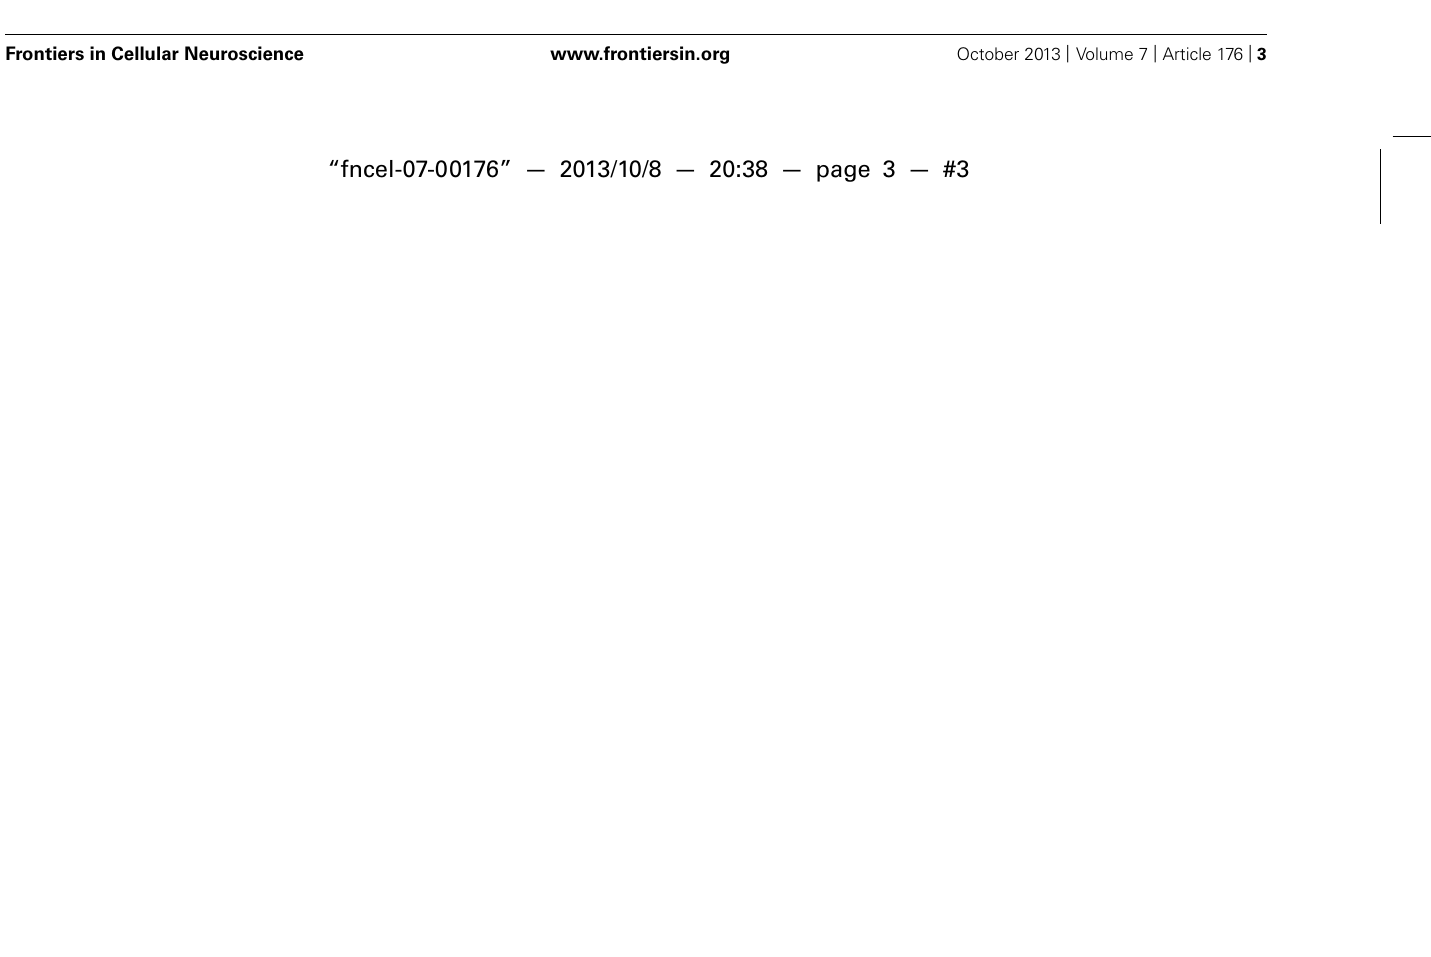
5 μ M rotenone for 6 h (C) , or 25 μ M A β peptide for 24 h (D) were fixed and stained using anti-cytochrome c antibodies and imaged using confocal microscopy (cytochrome c – red; YFP – green). Shown are representative pictures of at least three independent